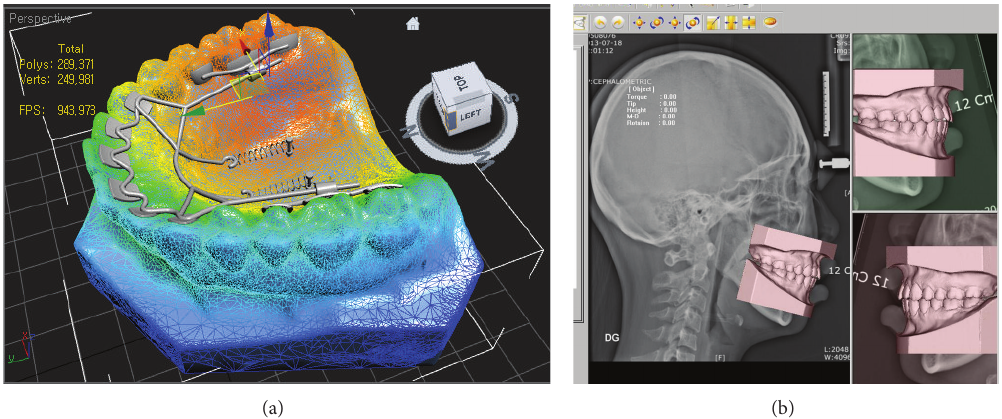
Figure 2: Three-dimensional (3D) model image was obtained by scanning the study model (a) and was registered with cephalograms in the 3Txer software (b).